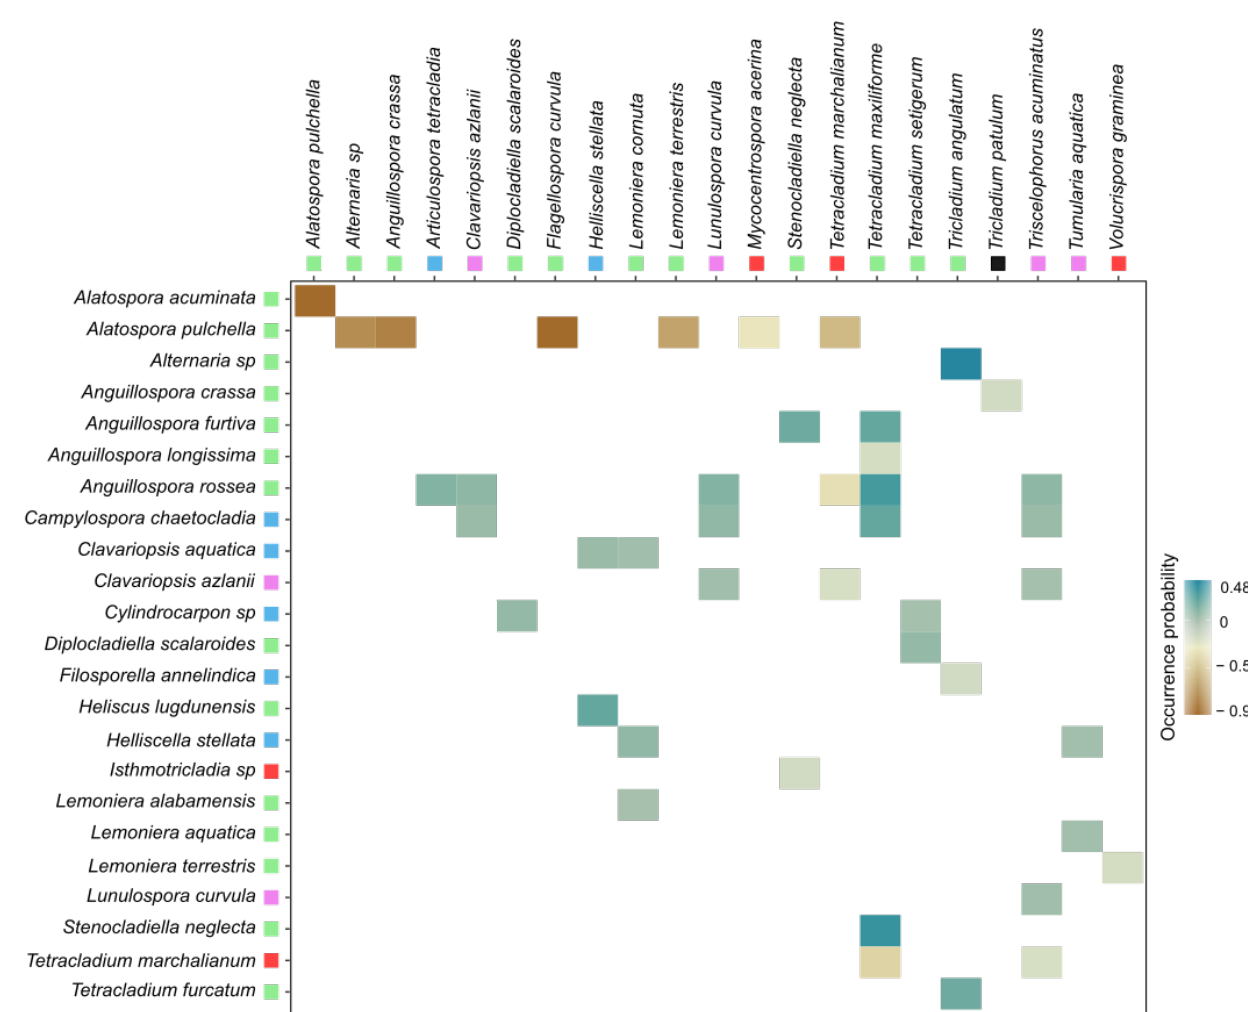
Figure 1. Heatmap showing significant co-occurrence probabilities among pairs of aquatic fungal species across the drying gradient. Colored squares next to species names represent their drying preferences and specializations: drying sensitive (pink), partly tolerant (blue), specialist (red), and generalist (green) [60]. Note that the black square indicates no information regarding the drying preference and specialization.